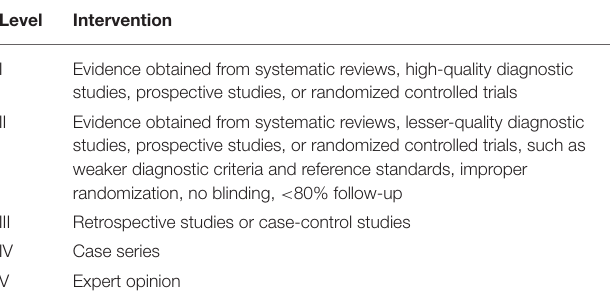
TABLE 1 | Oxford center for evidence based medicine, level of